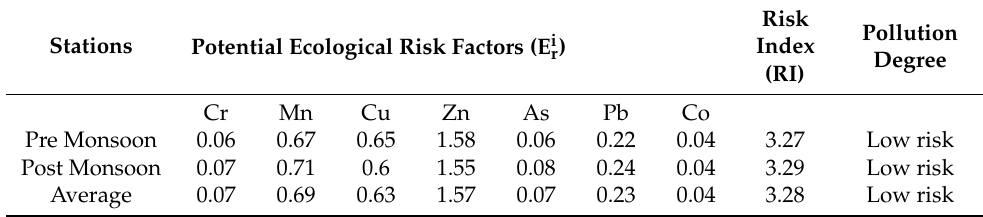
Table 6. Ecological risk factor and PER for heavy metal contaminated sediment